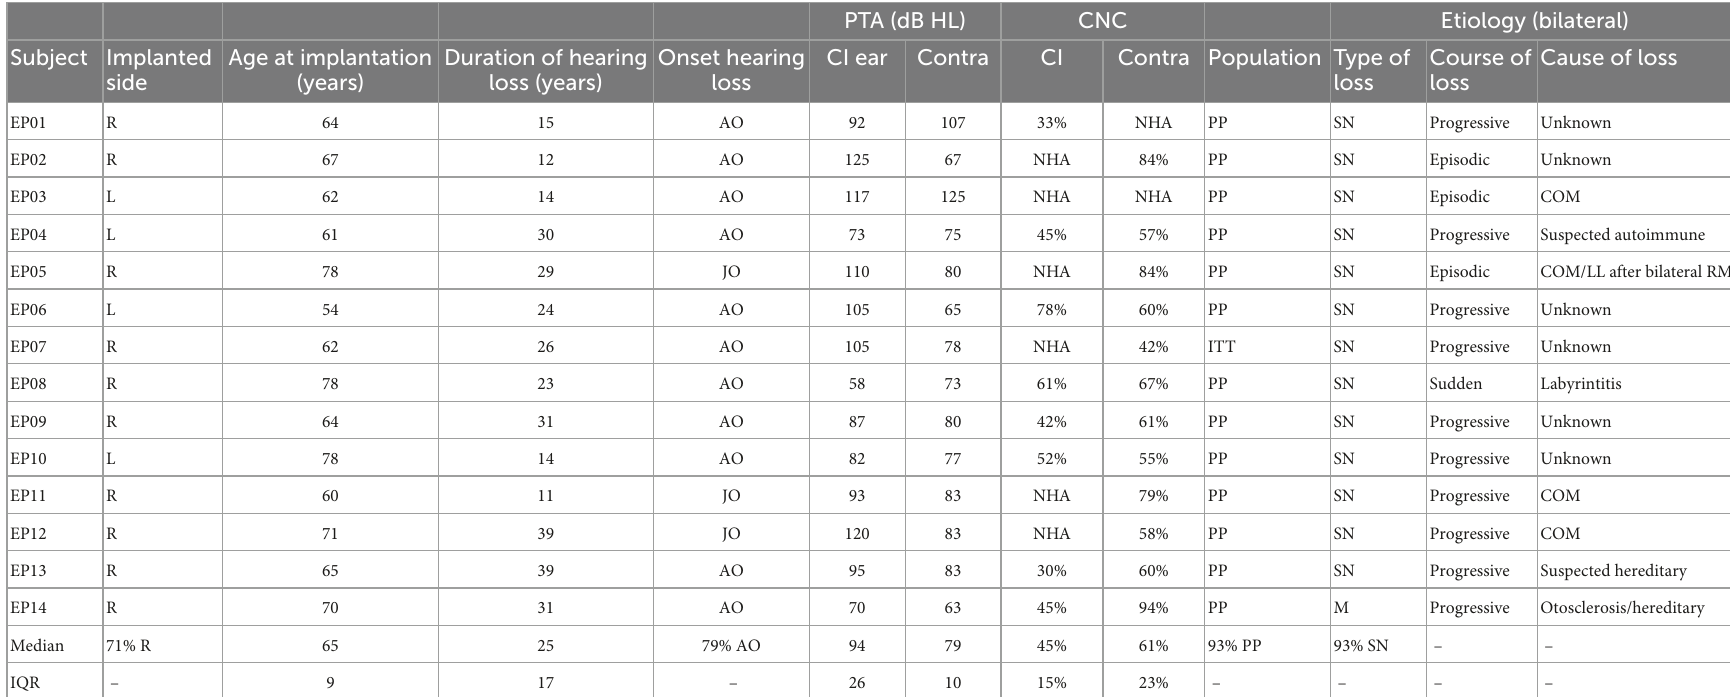
TABLE 2 Subject